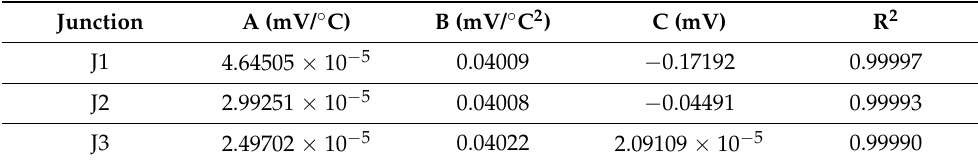
Figure 8. Static test results of the sensor. ( a ) The calibration curve of three junctions. ( b ) Comprehensive testing of sensors for multiple temperatures rises and falls. Table 4. Temperature response fitting curves for the three junctions of the